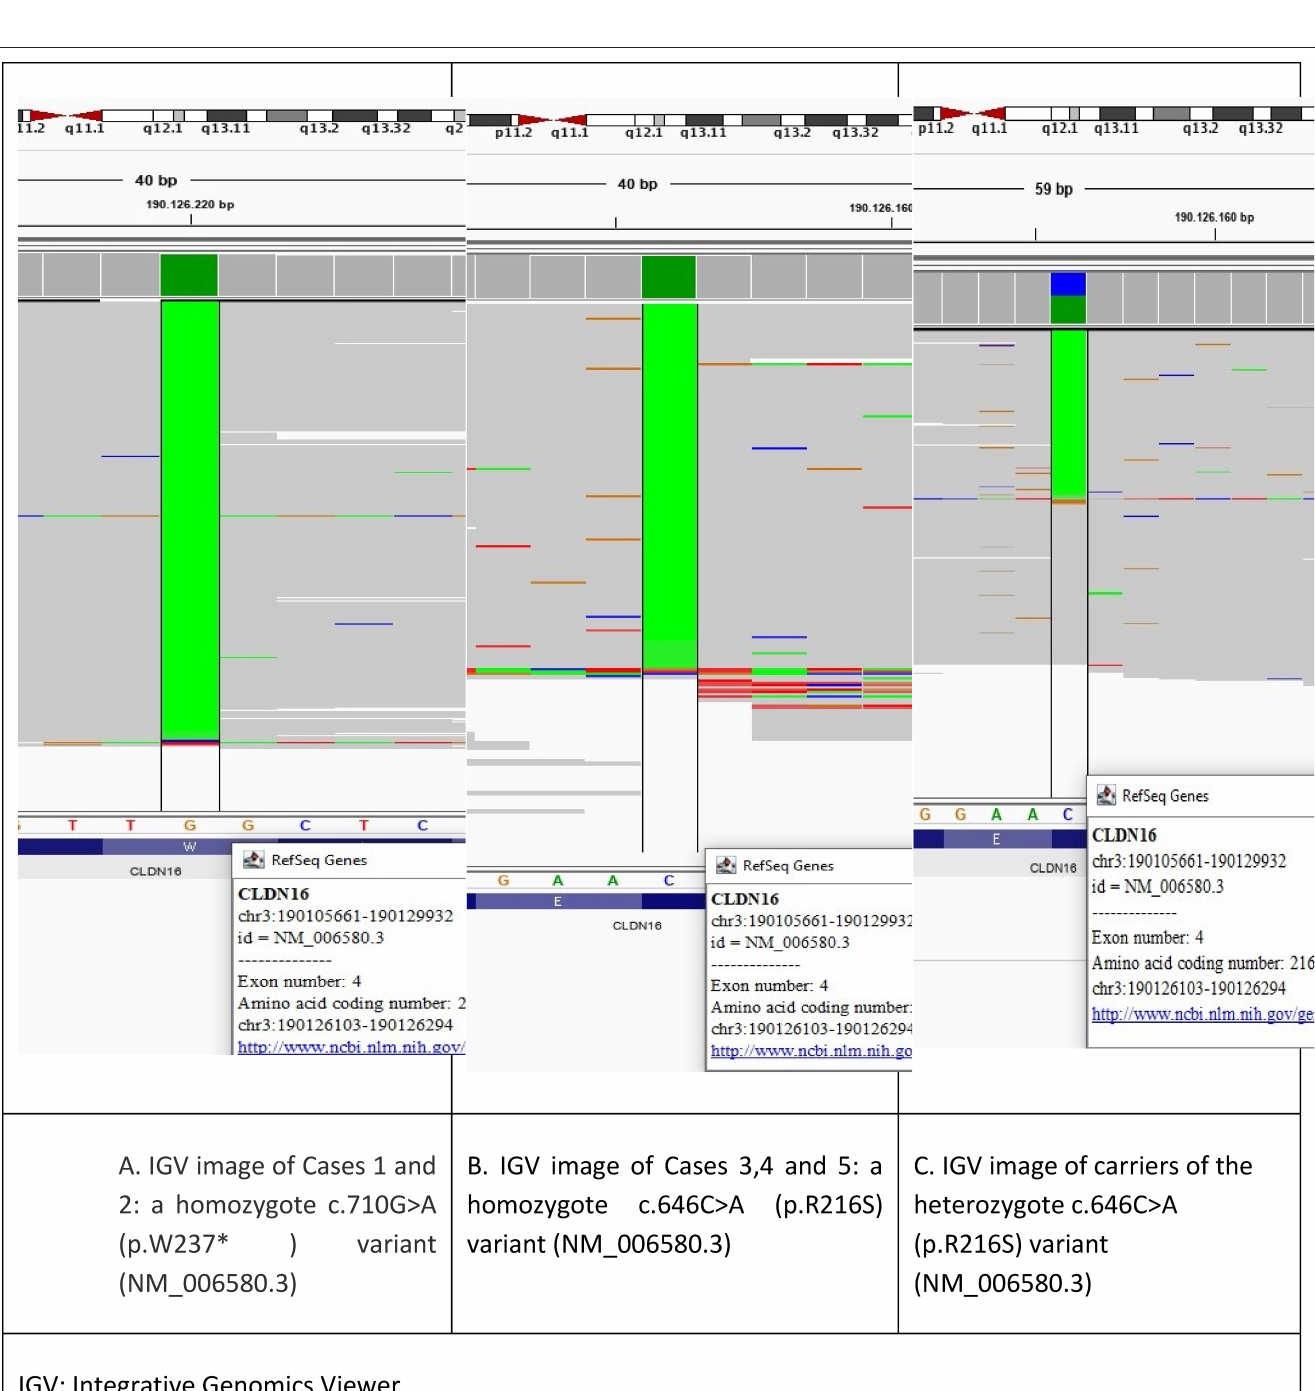
Figure 3. Genetic mutations of the